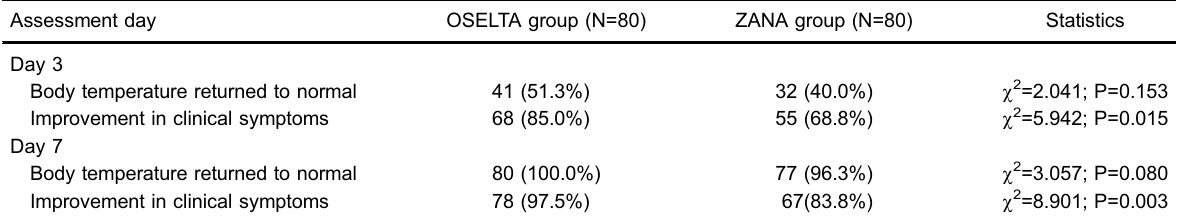
Table 3. Comparison of clinical improvement of in fl uenza non-speci fi c symptoms on days 3 and 7 of treatment of chronic obstructive pulmonary disease patients with in fl uenza virus infection treated with oral oseltamivir (OSELTA group) or inhaled zanamivir (ZANA group).